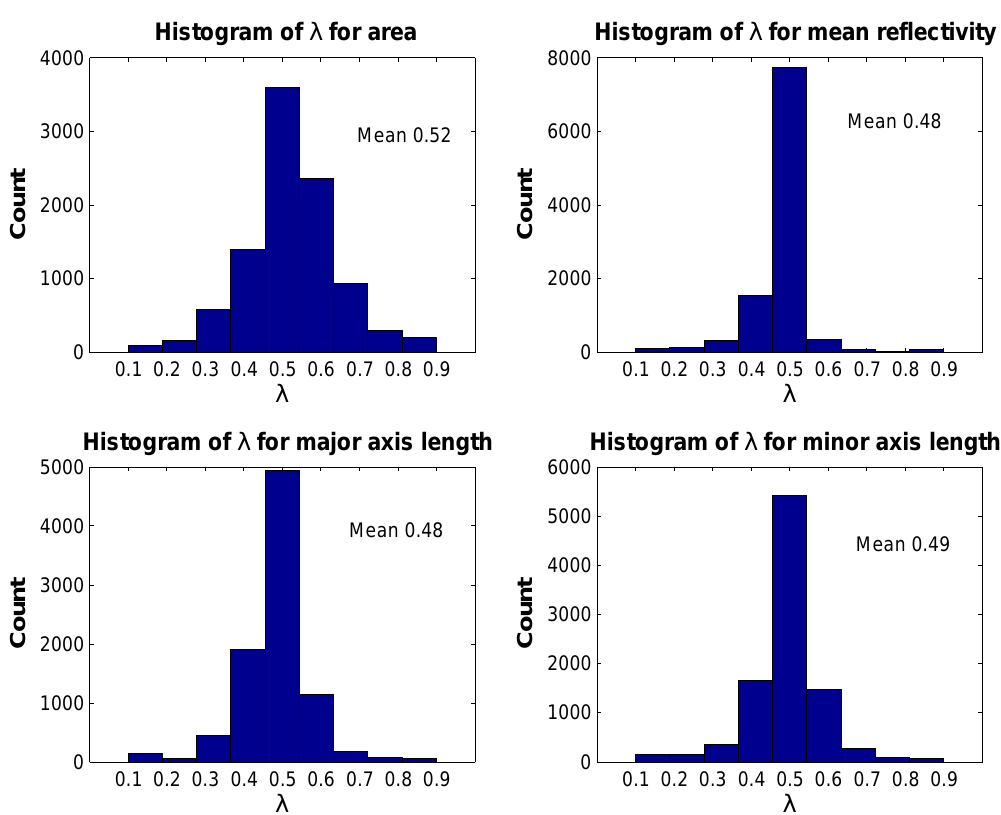
Figure 14. The histograms of lambda for which the minimum of the MSE is obtained while forecasting the area, mean reflectivity, major and minor axis lengths with a 5-min forecast leading time.